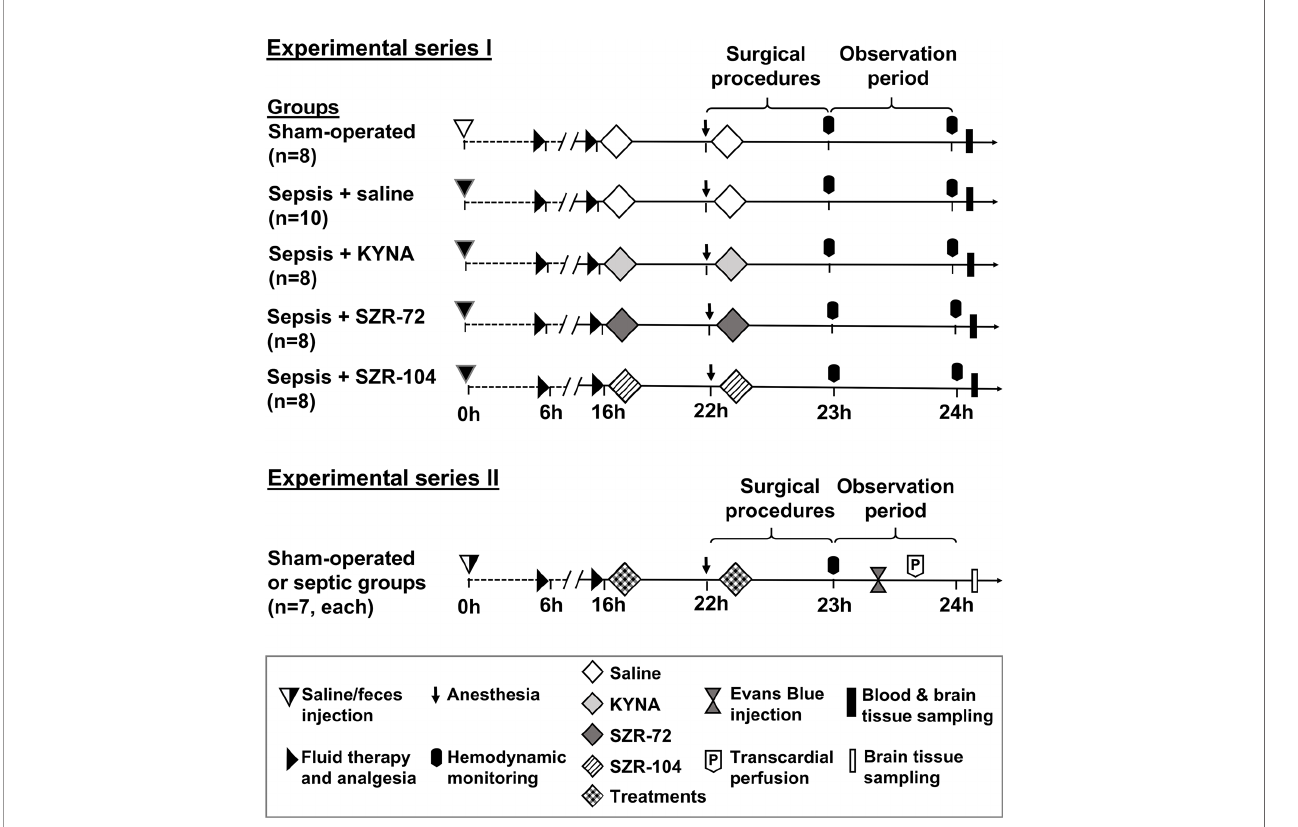
FIGURE 1 | The schemes for the experimental protocols (groups, interventions and assessments). In Series I, sampling for NETosis parameters and measurements of brain mitochondrial oxygen consumption were conducted, whereas blood – brain barrier permeability measurements were performed in Series II. The animals were randomly assigned to sham-operated or septic groups, which later was further divided into four independent groups according to the treatment (saline, KYNA, SZR- 72 or SZR-104) applied at the 16 th and 22 nd hours of